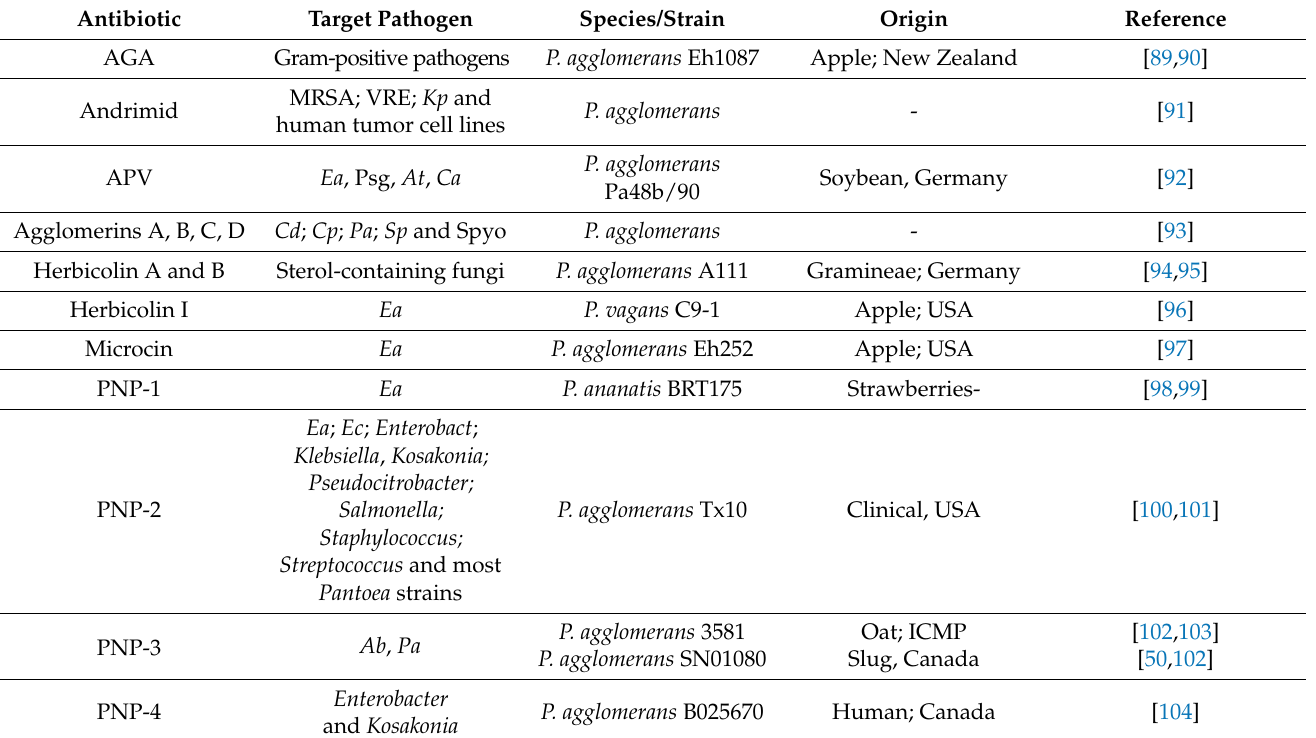
Table 2. Type of antibiotic produced by Pantoea